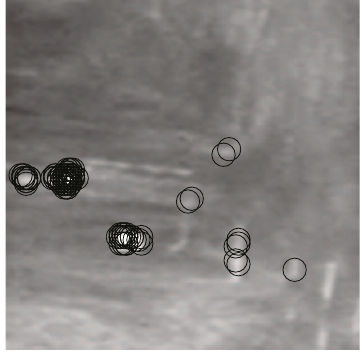
Figure 5: SIR resampling of p ( x k | z 1: k